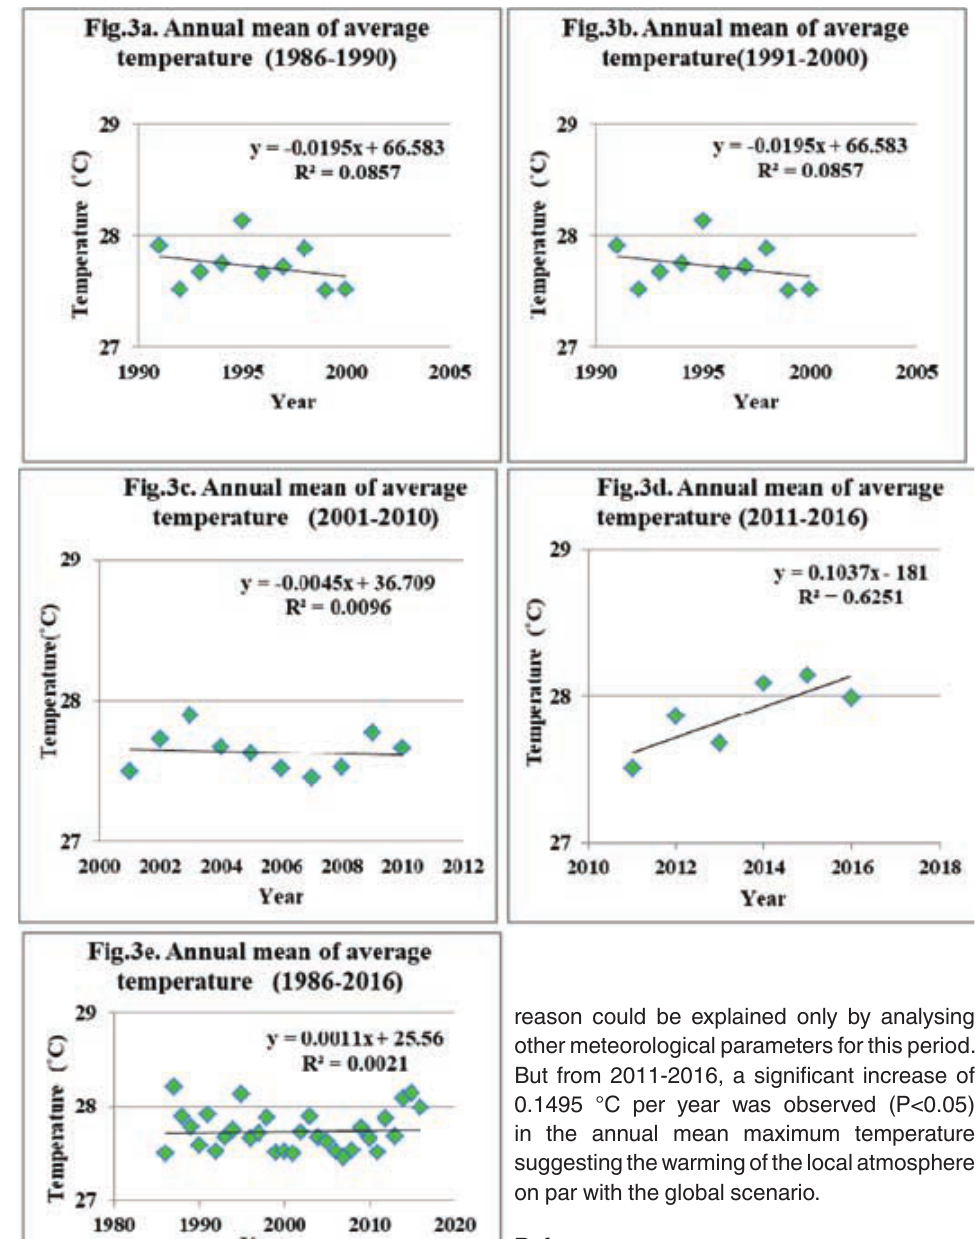
Fig.3. Trends in annual mean of average temperature from 1986 to